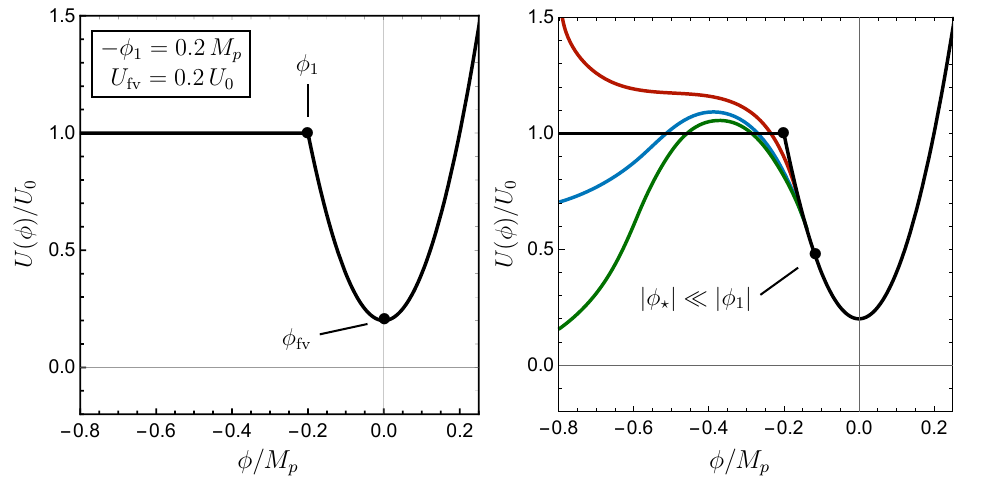
 ), together with more realistic examples Figure 5 . Left: the piecewise potential U ( φ ) from eq. (3.17), with φ toy  q = − m 2 R 2 5 3 M p indicates the point where the potential U ( φ ? 2 2